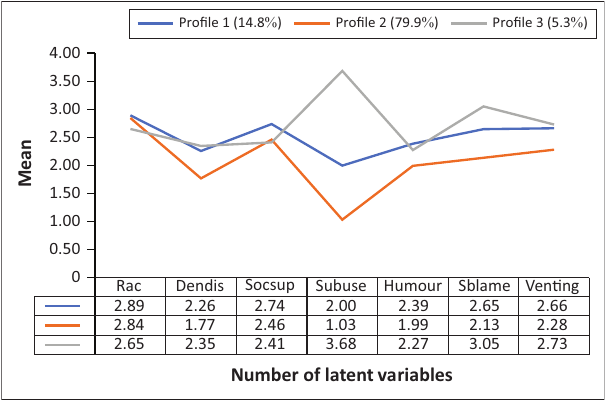
RAC, Positive reframing and active coping; DENDIS, denial and disengagement; SOCSUP, instrumental and emotional social support; SUBUSE, substance use; SBLAME, self-blame; VENTING, venting of emotions. FIGURE 2: Profiles of different types of copers.